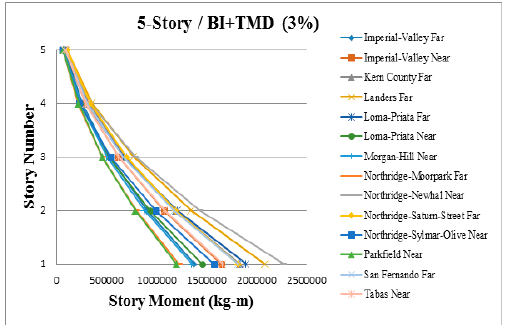
Figure A16. Peak story moments for 5-story base-isolated building with 1 TMD.